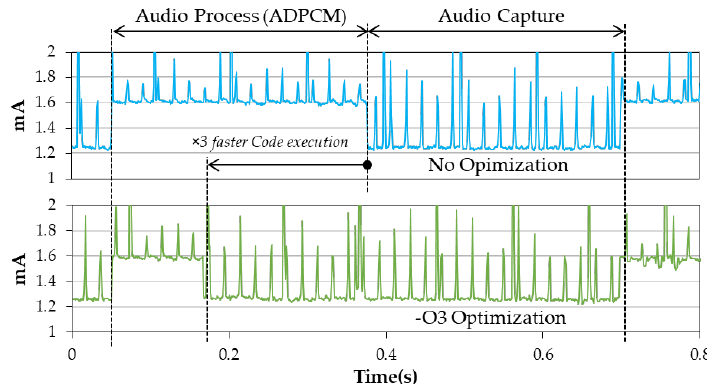
Figure 13. Effect of compiler optimization applied to the ADPCM algorithm on power consumption (1 KHz Tickless Idle